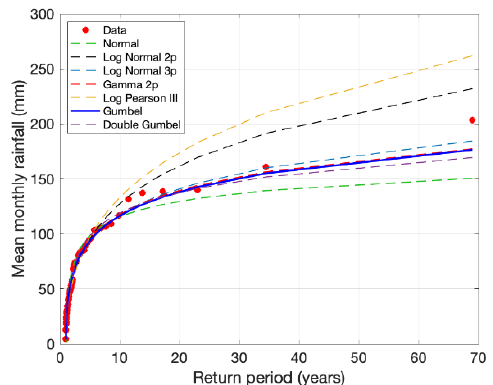
Figure 4. Fitting of the probability distributions to the mean monthly rainfall data for June in the function of the return period. function of the return period.